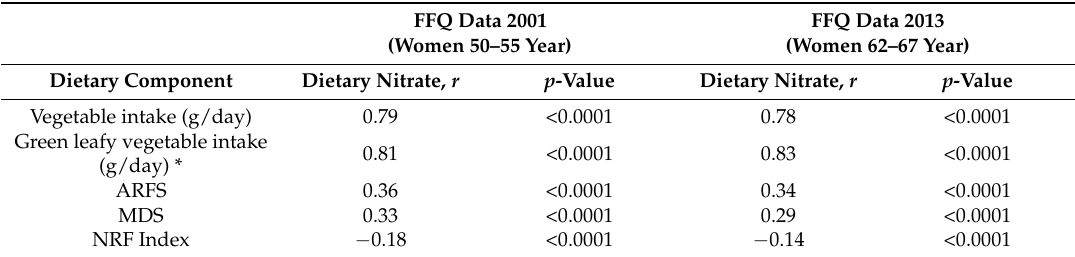
Table 5. Dietary components and diet quality correlations with total dietary